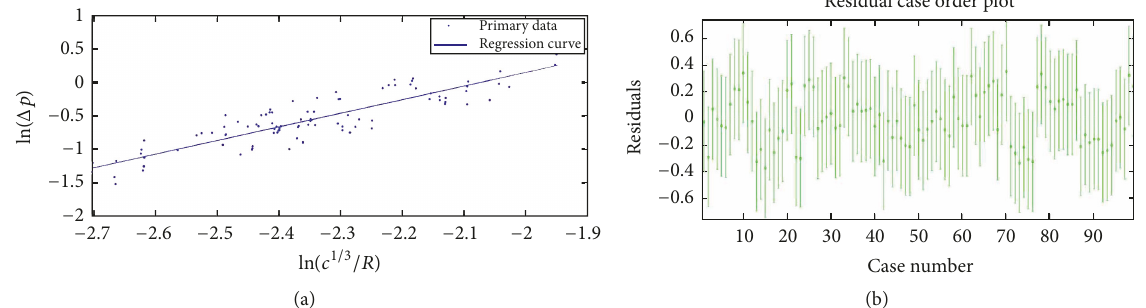
Figure 4: The final regression curve and residuals case order of the shock wave peak overpressure.